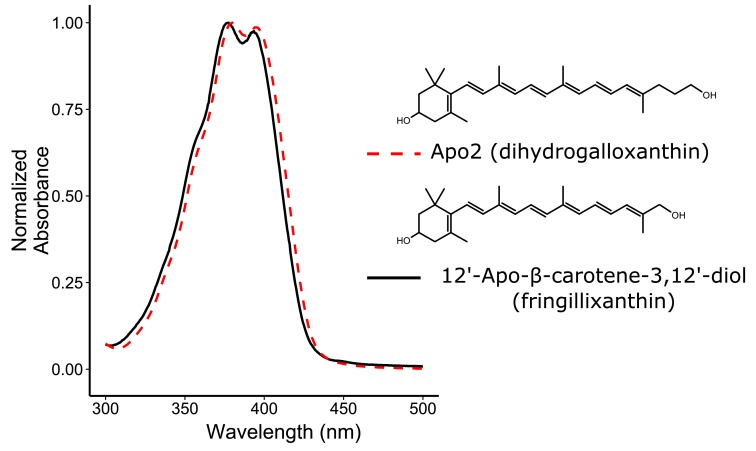
The absorbance spectra of Apo2 and 12'-Apo-β-carotene-3,12'-diol (fringillixanthin) are nearly identical.A comparison of the UV-Vis spectrum and chemical structure of Apo2 (dihydrogalloxanthin) and 3-OH-apo-12’-carotenol (fringillixanthin).